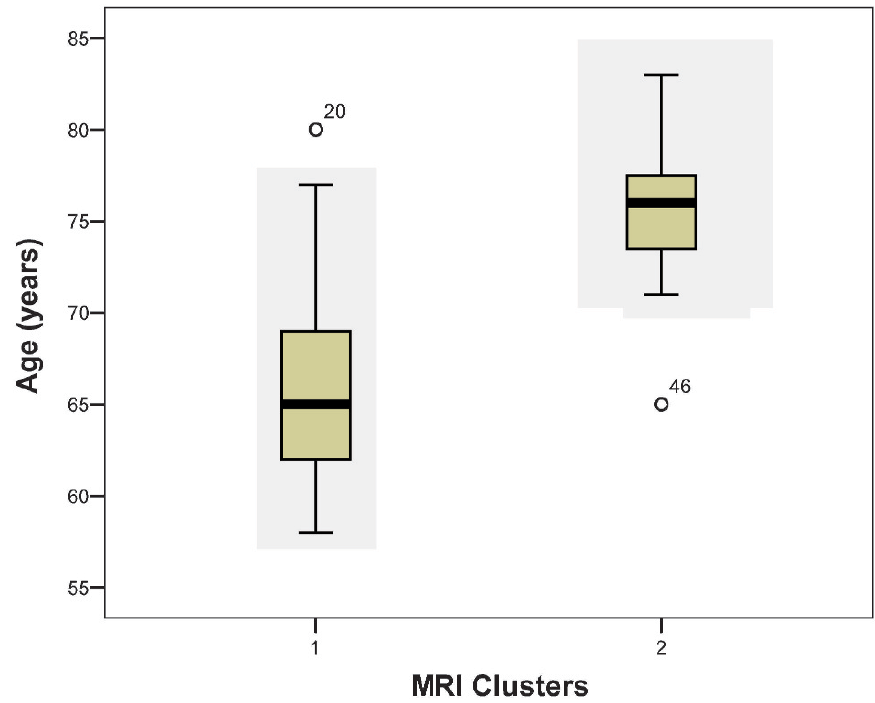
Figure 3 - Relationship between Age and